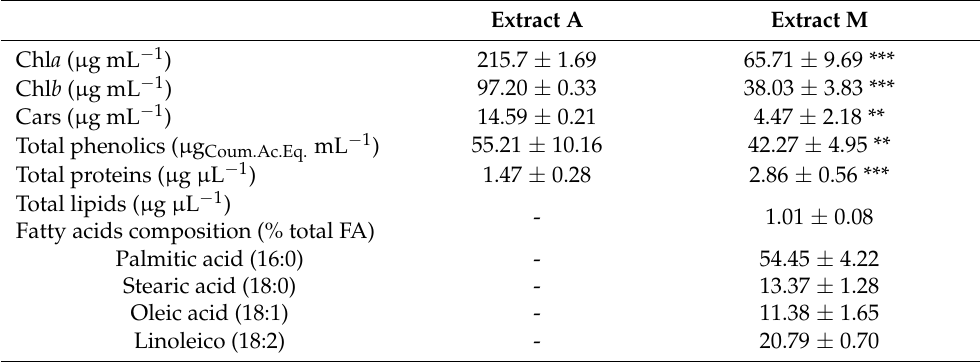
Table 1. Chemical characterization of N. oleoabundans extract A and M, obtained from autotrophic (A) and mixotrophic (M) cultures at 28 and 12 d of cultivation, respectively, and used for antiviral tests. Data refer to means ± standard deviations ( n ≥ 8 for pigments, phenolics and protein quantification; n = 3 for fatty acids profile). Except for lipids, for each compound or class of compounds, asterisks identify significant differences between culture A and M: **, p < 0.01; ***, p < 0.001.